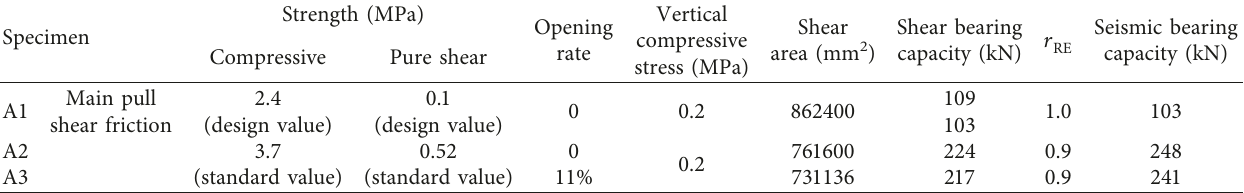
Table 8: Calculated values for seismic shear capacity of three test walls.